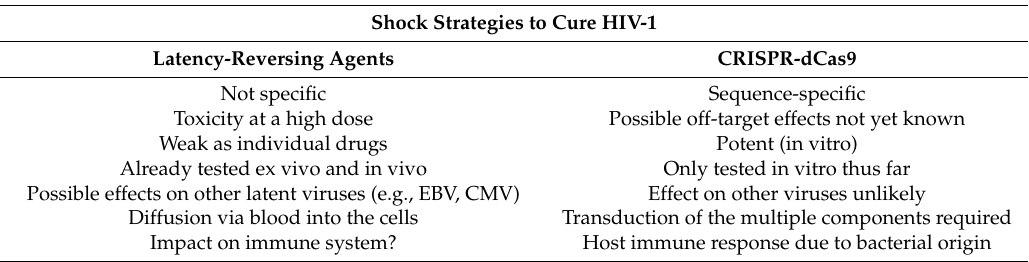
Table 1. Strengths and weaknesses of pharmacological and CRISPR-based shock